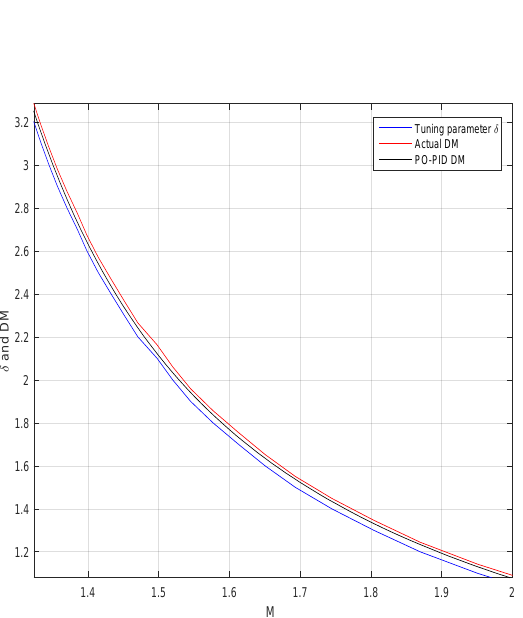
Figure 11: Illustration of the tuning parameter δ , the actual relative Delay Margin (DM) and the POI-PID DM as a function of robustness M s . PID controller tuning Alg. 2.1 and Eq. (27) with varying relative delay margin δ for a DIPTD plant with K = 1 and τ = 1.